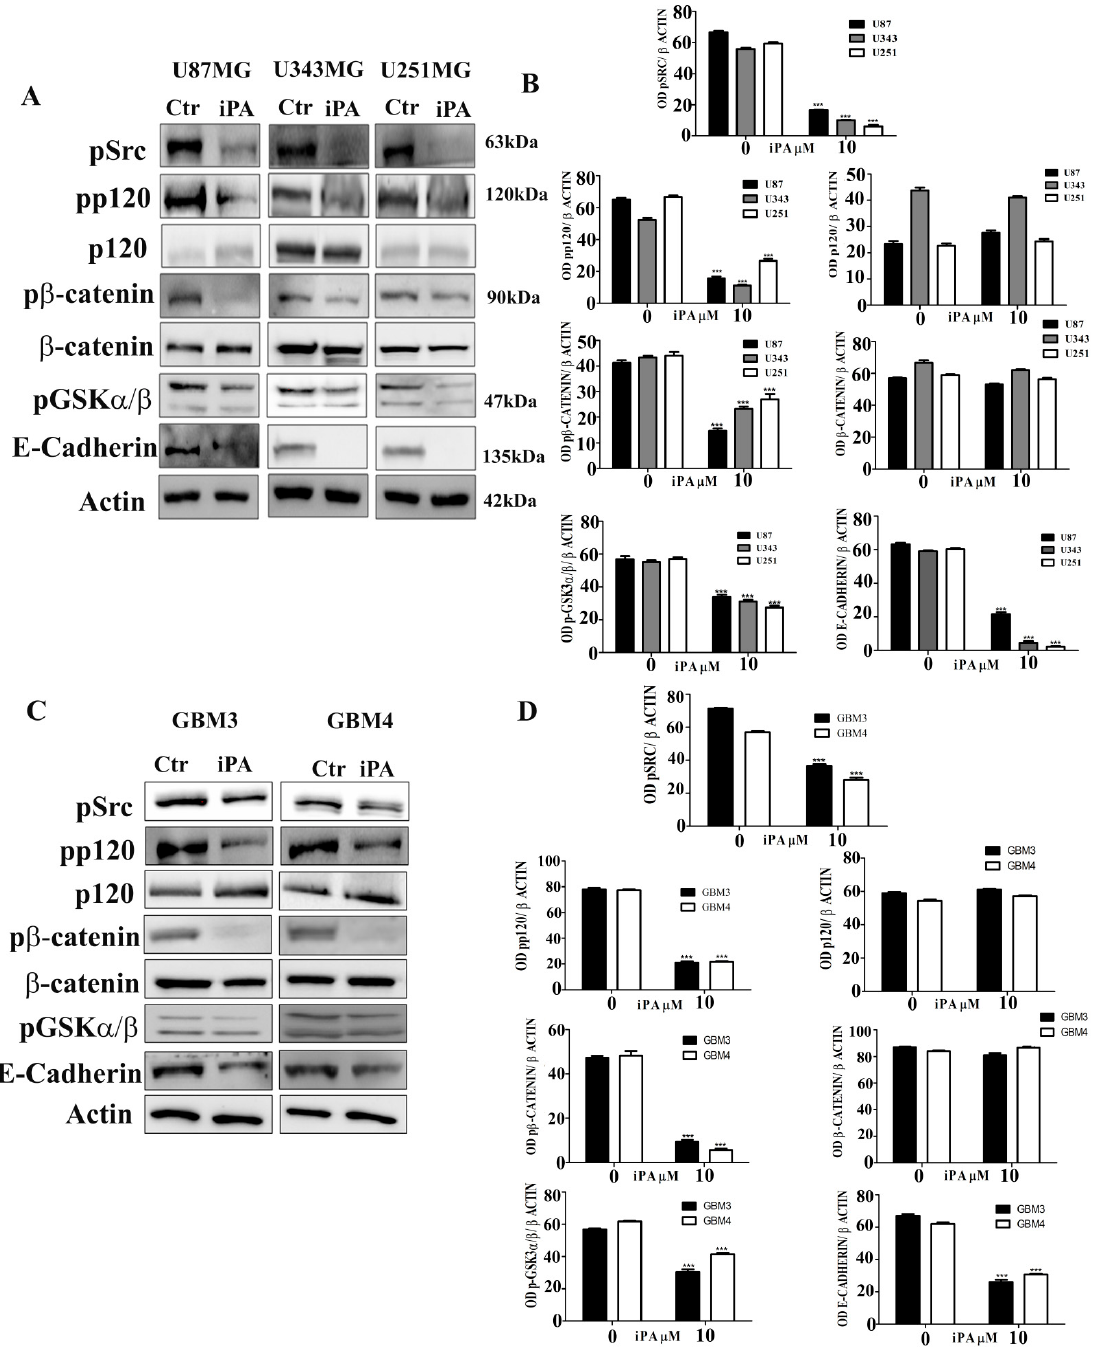
Figure 4. Western Blot analysis was used to assess iPA effect on levels of AJ proteins at 18 h ( A ) iPA reduced pSrc, pp120 catenin, p β -catenin, pGSK3 α / β and E-cadherin protein in U87MG, U343MG, and U251MG stabilized cell lines. ( B ) Densitometric analysis of each Western Blot. ( C ) iPA effect on AJ protein levels at 18 h on GBM primary cell lines (GBM3 and GBM4), iPA reduced pSrc, pp120 catenin, p β -catenin, pGSK3 α / β , and E-cadherin protein. ( D ) Densitometric analysis of each Western Blot. Results are expressed as the mean ± SD of four independent experiments conducted in triplicate. (ANOVA, *** p <